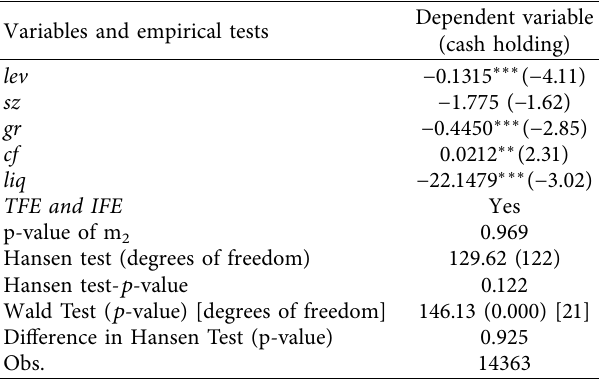
Table 12: Calculation of residuals for cash holding deviation es- timation (GMM